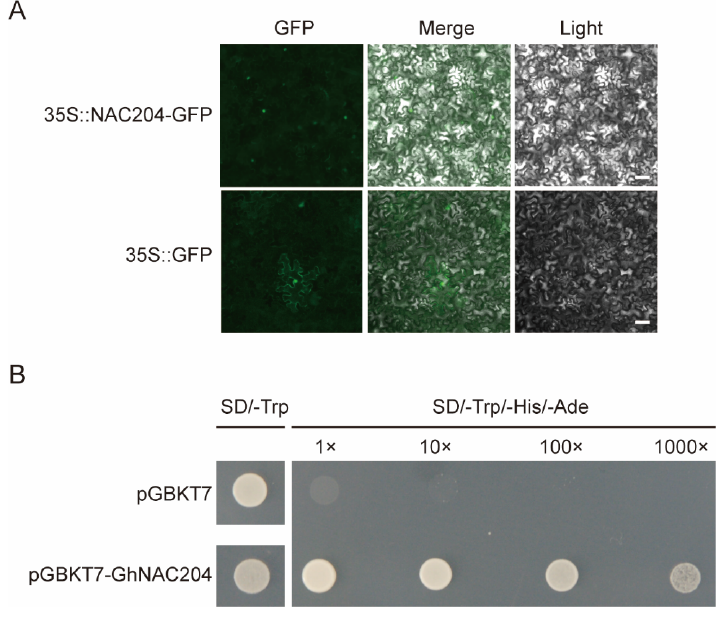
Figure 5. Subcellular localization and transcriptional activity identification of GhNAC204. ( A ) Lo- calization of GhNAC204 in N. benthamiana leaves. GhNAC204 was detected on the nuclei; 35 S: GFP as control was detected on the cytoplasm and nuclei; scale bar is 1 mm. ( B ) GhNAC204 has tran- scriptional activation activity. The GhNAC204-pGBKT7-positive yeast strains’ normal growth in yeast three-deficient medium SD/-Trp/-His/-Ade. SD/-Trp: yeast single deficiency medium; SD/- Trp/-His/Ade: yeast three deficiency medium; pGBKT7: negative control. Plants 2022 , 11 , x FOR PEER REVIEW Given that GhNAC204 was significantly induced by V. dahliae stress, we examined whether it is possible to weaken V. dahliae resistance by the knockdown of the expression level of GhNAC204 . To verify this conjecture, we used VIGS (virus-induced gene silencing) to knock down the expression level of GhNAC204 in Z2. The expression level of GhNAC204 was measured using roots from TRV:00 and TRV: GhNAC204 plants approxi- mately 4 weeks after infiltration (Figure 6A). Compared with TRV:00 plants, TRV:GhNAC204 plants showed severe disease symptoms including leaf chlorosis and wilting, vascular browning in the stem, and an elevated disease index after inoculation with V. dahliae (Figure 6B,C). The fungal recovery assay showed that the number of fungal colonies in the stem segments from TRV:00 plants was far less than that from TRV:GhNAC204 plants (Figure 6C). Taken together, these data indicated that GhNAC204 could be a positive regulator in cotton resistance to V. dahliae infection.